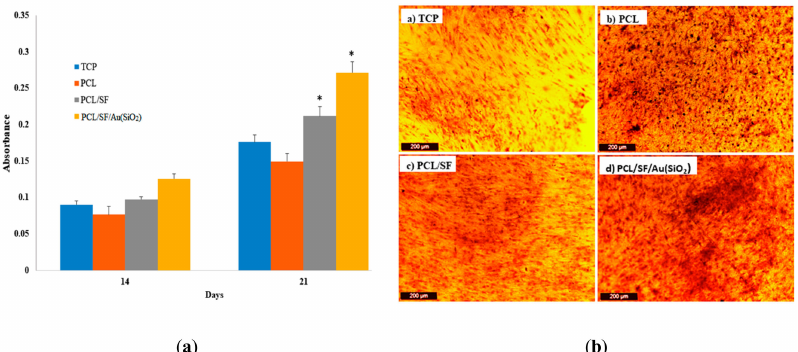
Figure 9. ( a ) Quantitative analysis of the mineralization by osteogenic di ff erentiation of MSCs on the di ff erent sca ff olds. ( b ) Optical microscope images showing the secretion of ECM by osteogenic di ff erentiation of MSCs using Alizarin red staining on day 21 on a) TCP, b) PCL, c) PCL / SF and d) PCL / SF / Au(SiO 2 ) nanofibrous sca ff olds at 10 × magnification (Scale bar: 200 µ m). * p <